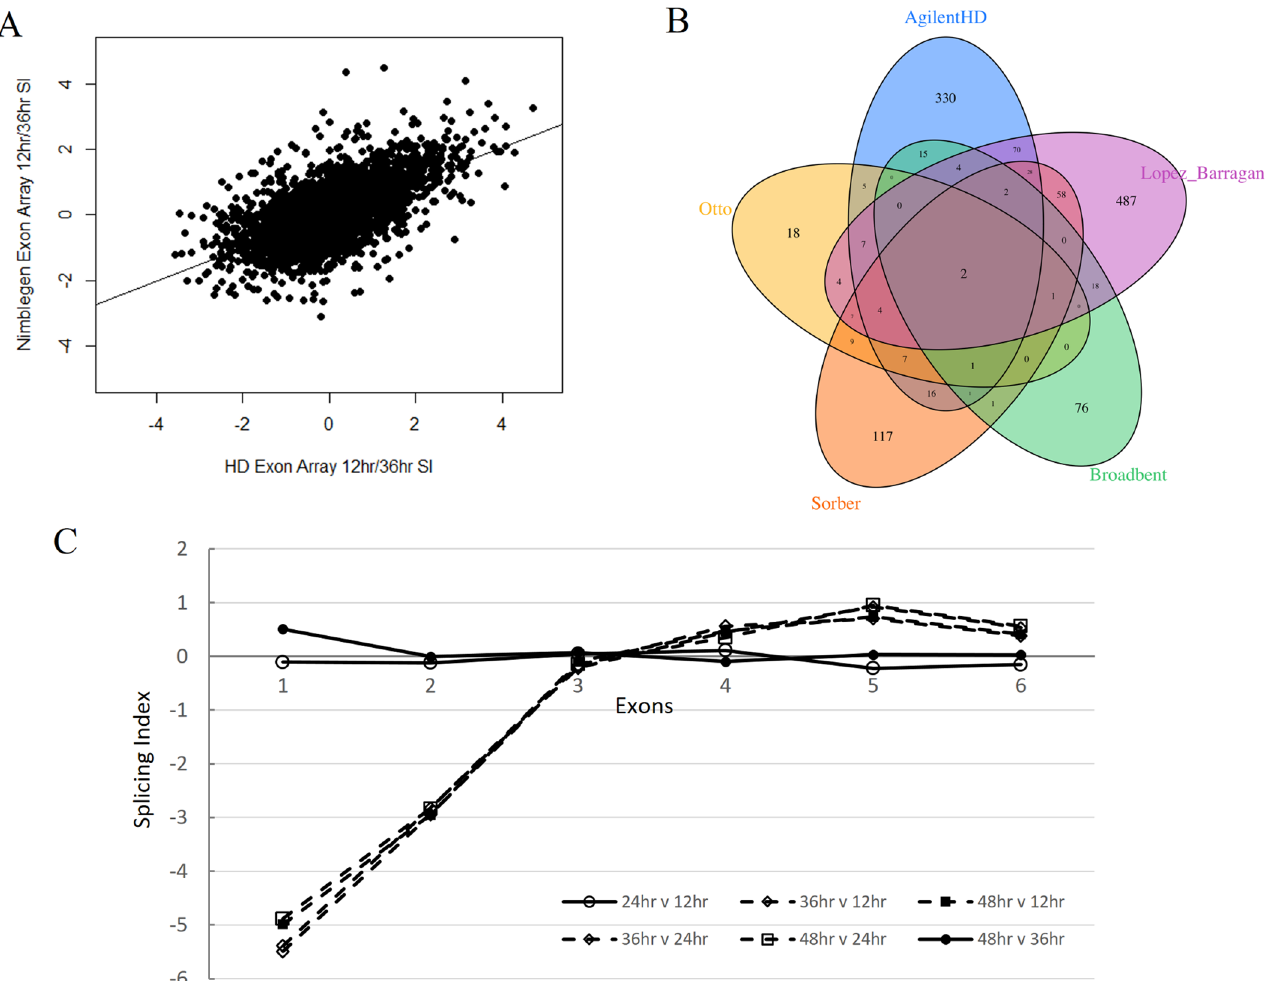
Fig 4. Exon arrayscan detect exon skipping transcript isoforms. Comparison of genes with transcript isoforms (A) Differential exon splicing is detected on both Nimblegenand Agilent HD exon array platforms using splicingindex with a correlationof 0.626. (B) Venn Diagramshowingthe overlap of geneswith transcript isoforms reportedby the Agilent HD Exon Array (blue) and RNA-seq studies (Otto (yellow),Sorber (orange), Broadbent(green), and Lopez-Barragen (purple) [24,25,36,37]), (C) Alternativestart sites for PF3D7_0929200 producetime point dependentexon skippingof exons 1 and 2 duringthe schizont parasite stage at 36 and 48